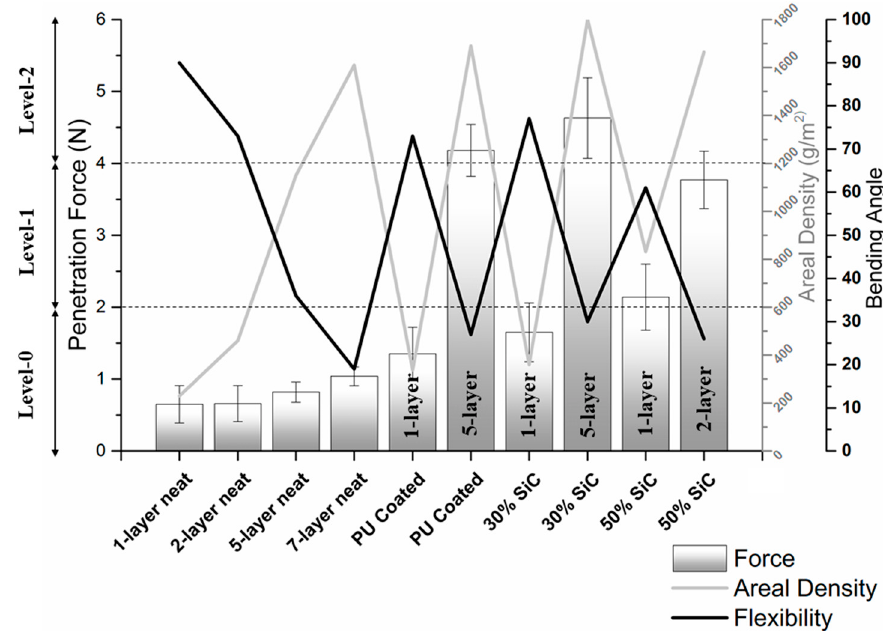
Figure 8. Measured peak resistance force, bending angle, and areal density of plasma-treated neat and coated UHMWPE fabric of various layers undergoing 25G needle penetration tests.